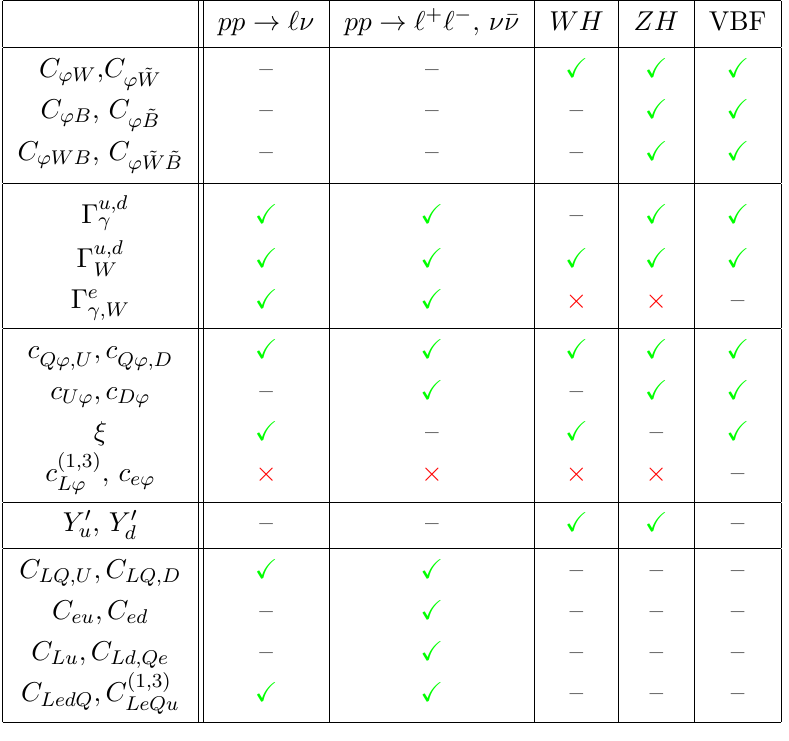
Table 2 . Contributions of the dimension-six operators in eqs. (2.5), (2.6), (2.8), (2.9) and (2.10)